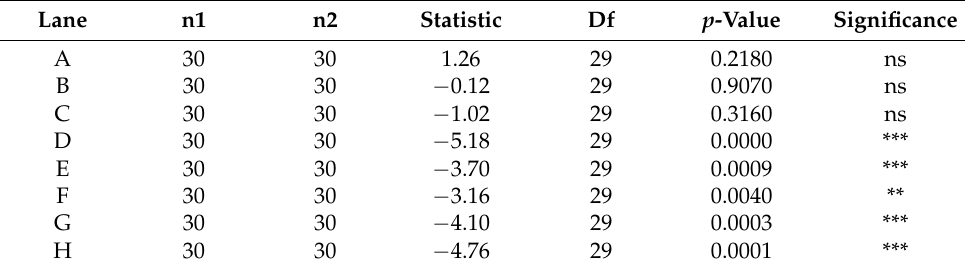
Table 1. Pairwise t -test between lanes of a 96-well microplate containing flag leaf extracts with different protein concentration (see text for further details) #